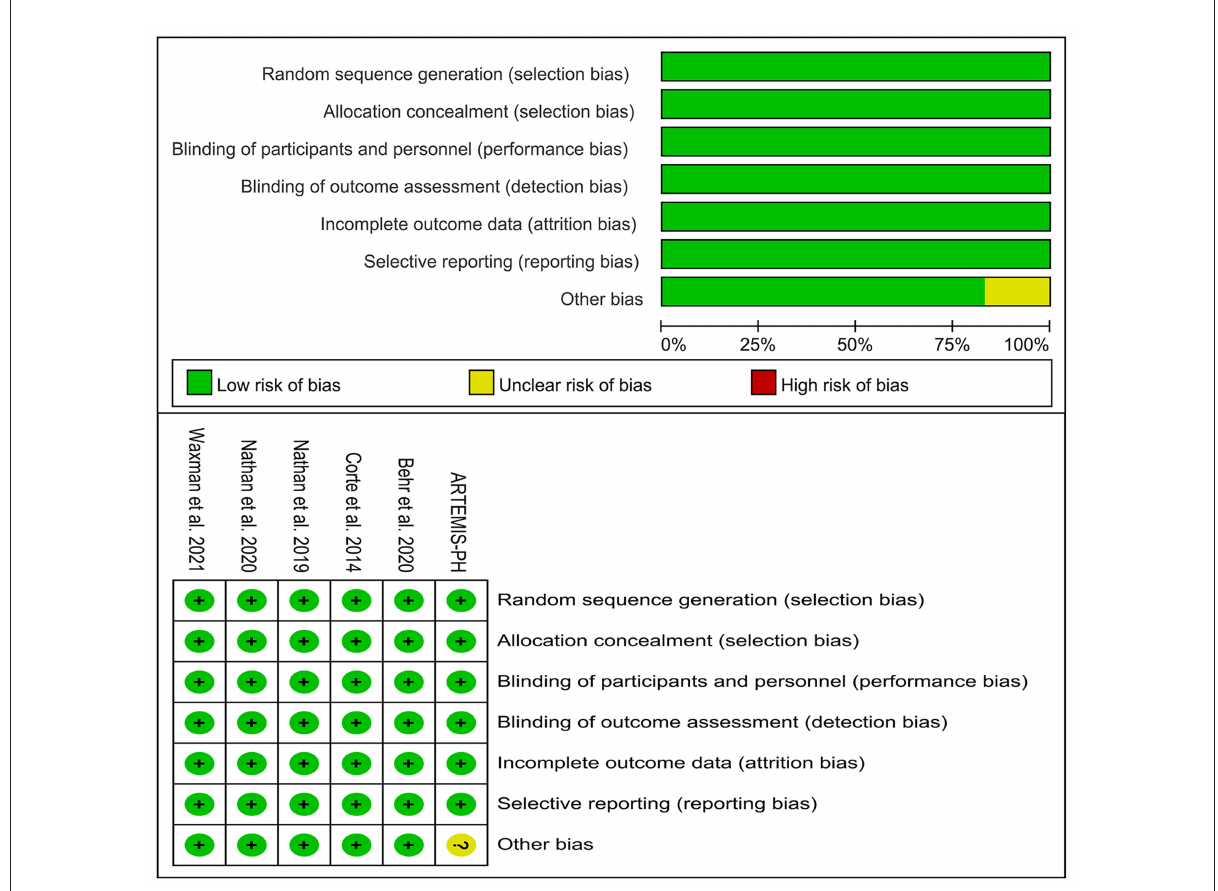
FIGURE2 Risk of bias assessment of included studies.